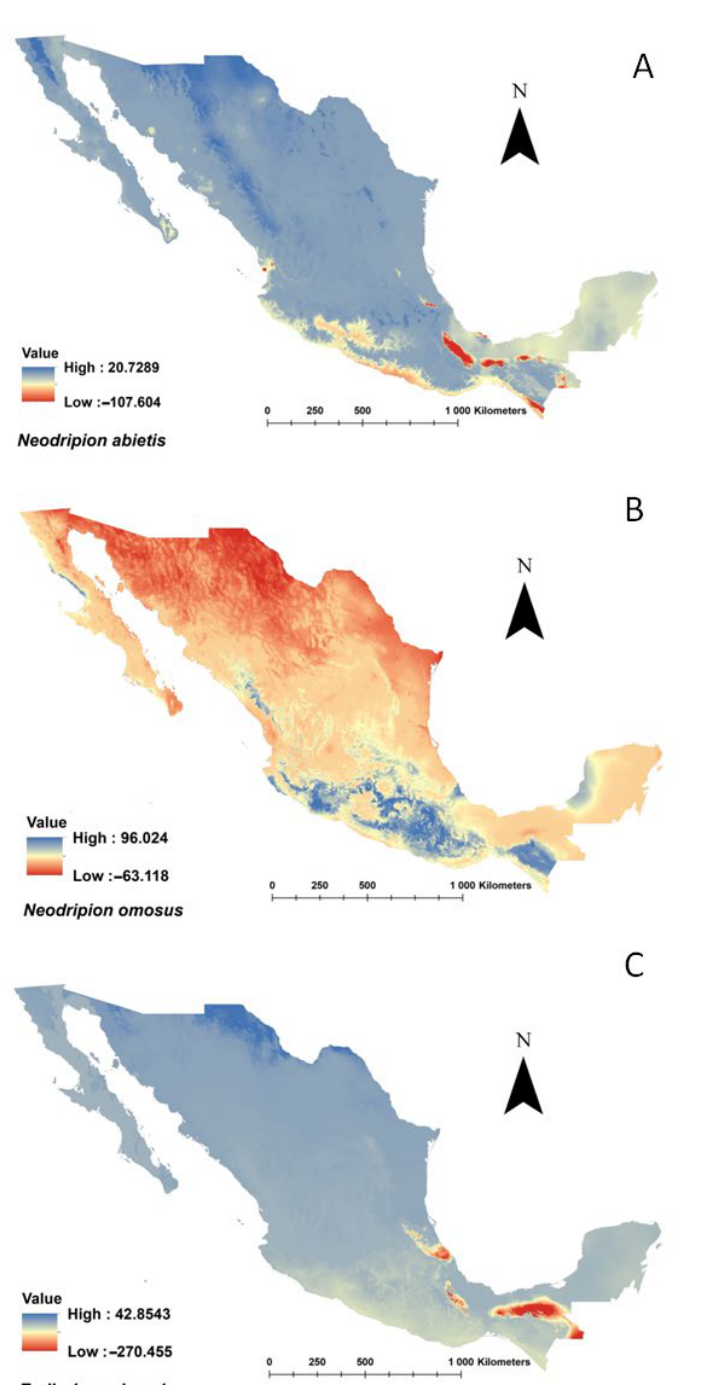
Figure 3. MESS analysis for three sawflies (Hymenoptera: Diprionidae) in Mexico, projected ac- cording to the Mexican biogeographic provinces [53]. ( A ) Neodriprion abietis , ( B ) N. omosus and ( C ) Zadiprion rohweri . For biogeographic provinces, check Figure 1.